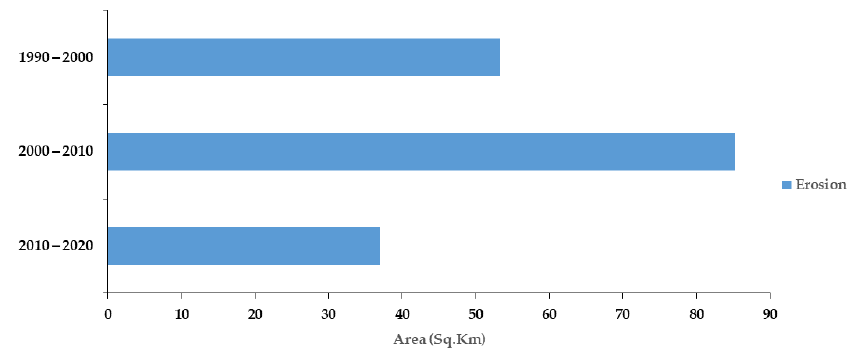
Figure 3. Decadal erosion occurred across the Bhagirathi - Hugli River.